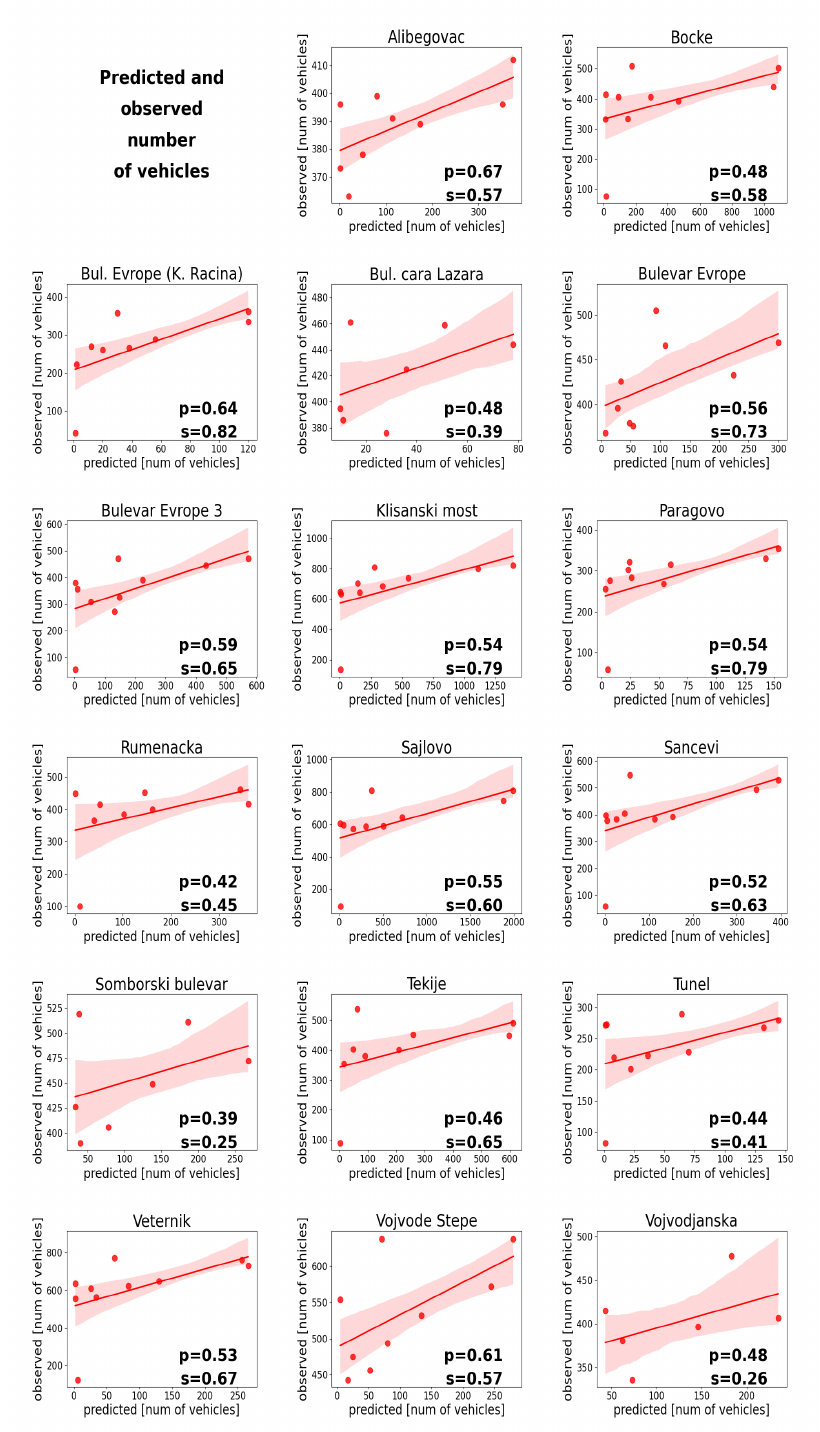
Figure 6. Calibration—Pearson (p) and Spearman (s) correlation coefficients between predicted and observed numbers of cars in automatic vehicle counters data set. The selected day from automatic vehicle counters data set was 6 November 2019. Please note: the axes are not in the same scale to emphasize the captured